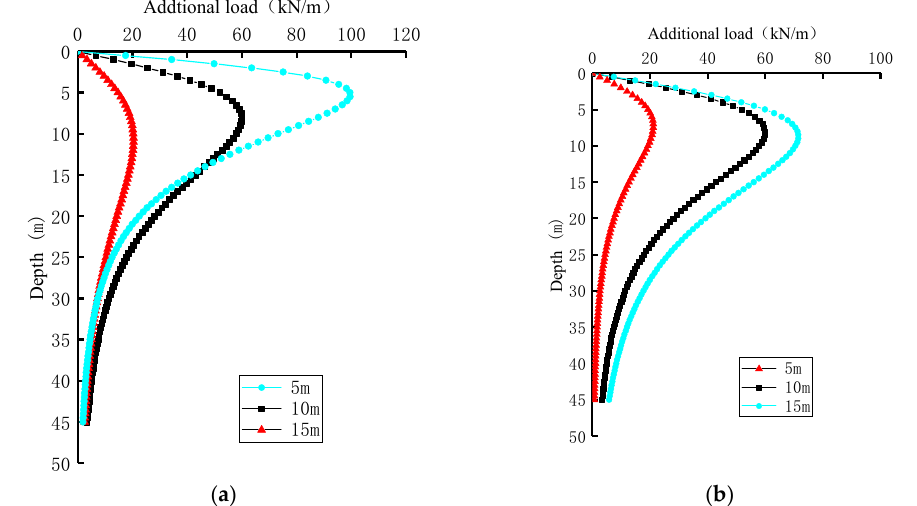
Figure 9. The additional load acting on the pile shaft (surcharge strength is 70 kPa; surcharge length ( A ) is 25 m). ( a ) Additional load changing with depth with different surcharge distances (surcharge width ( B ) is 10 m). ( b ) Additional load changing with depth with different surcharge widths (surcharge distance € is 10 m).